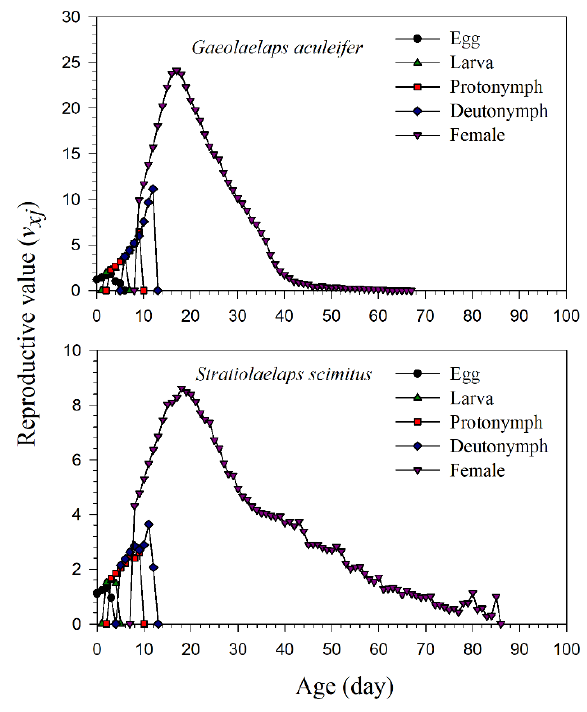
Figure 5. Age-stage-specific reproductive value ( v xj ) of G. aculeifer and S. scimitus fed on T. putrescentiae .